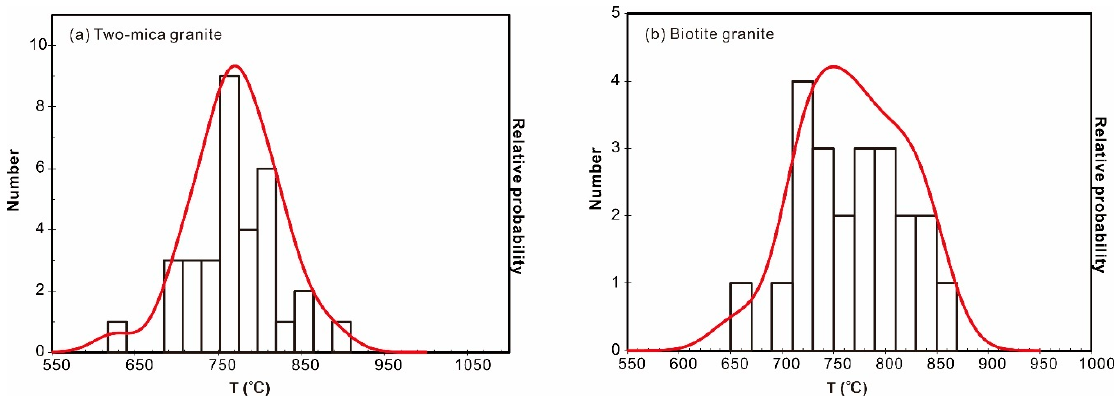
Figure 8. Cumulative probability histograms of the Ti-in-zircon thermometer [31] for the two-mica granite ( a ) and biotite granite ( b ).